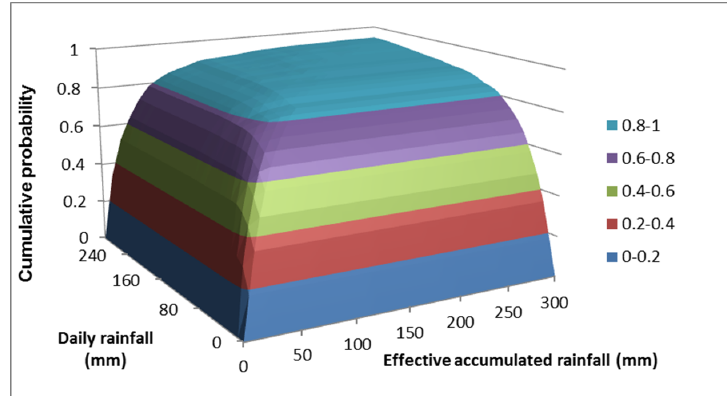
Figure 6. The joint cumulative distribution function for the Bihu rain gauge.